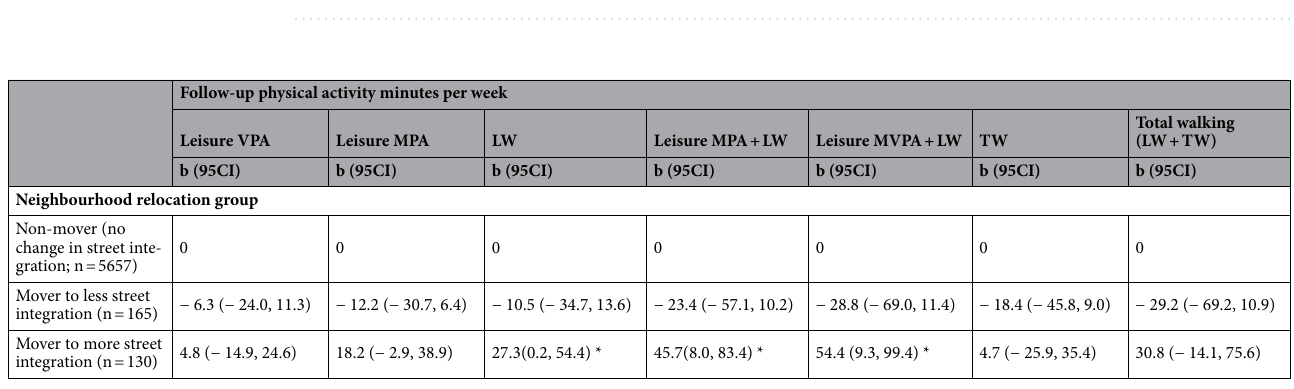
Table 2. Baseline, follow-up, and exposure street integration estimates by neighbourhood relocation. Same superscript ( a,b,c ) represents statistically significant (p < .05) difference in integration and exposure between neighbourhood relocation groups (ANOVA and Least Significant Difference post hoc tests).